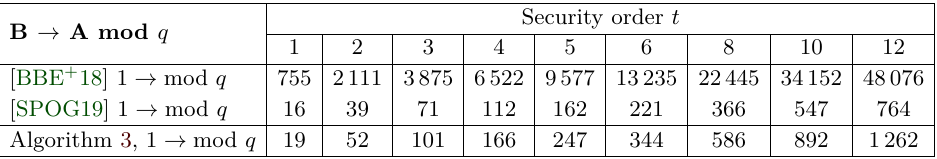
Table 4: Operation count for 1-bit Boolean to arithmetic modulo q conversion algorithms, up to security order t = 12, with n = t + 1 shares, for prime q = 3329. B → A mod